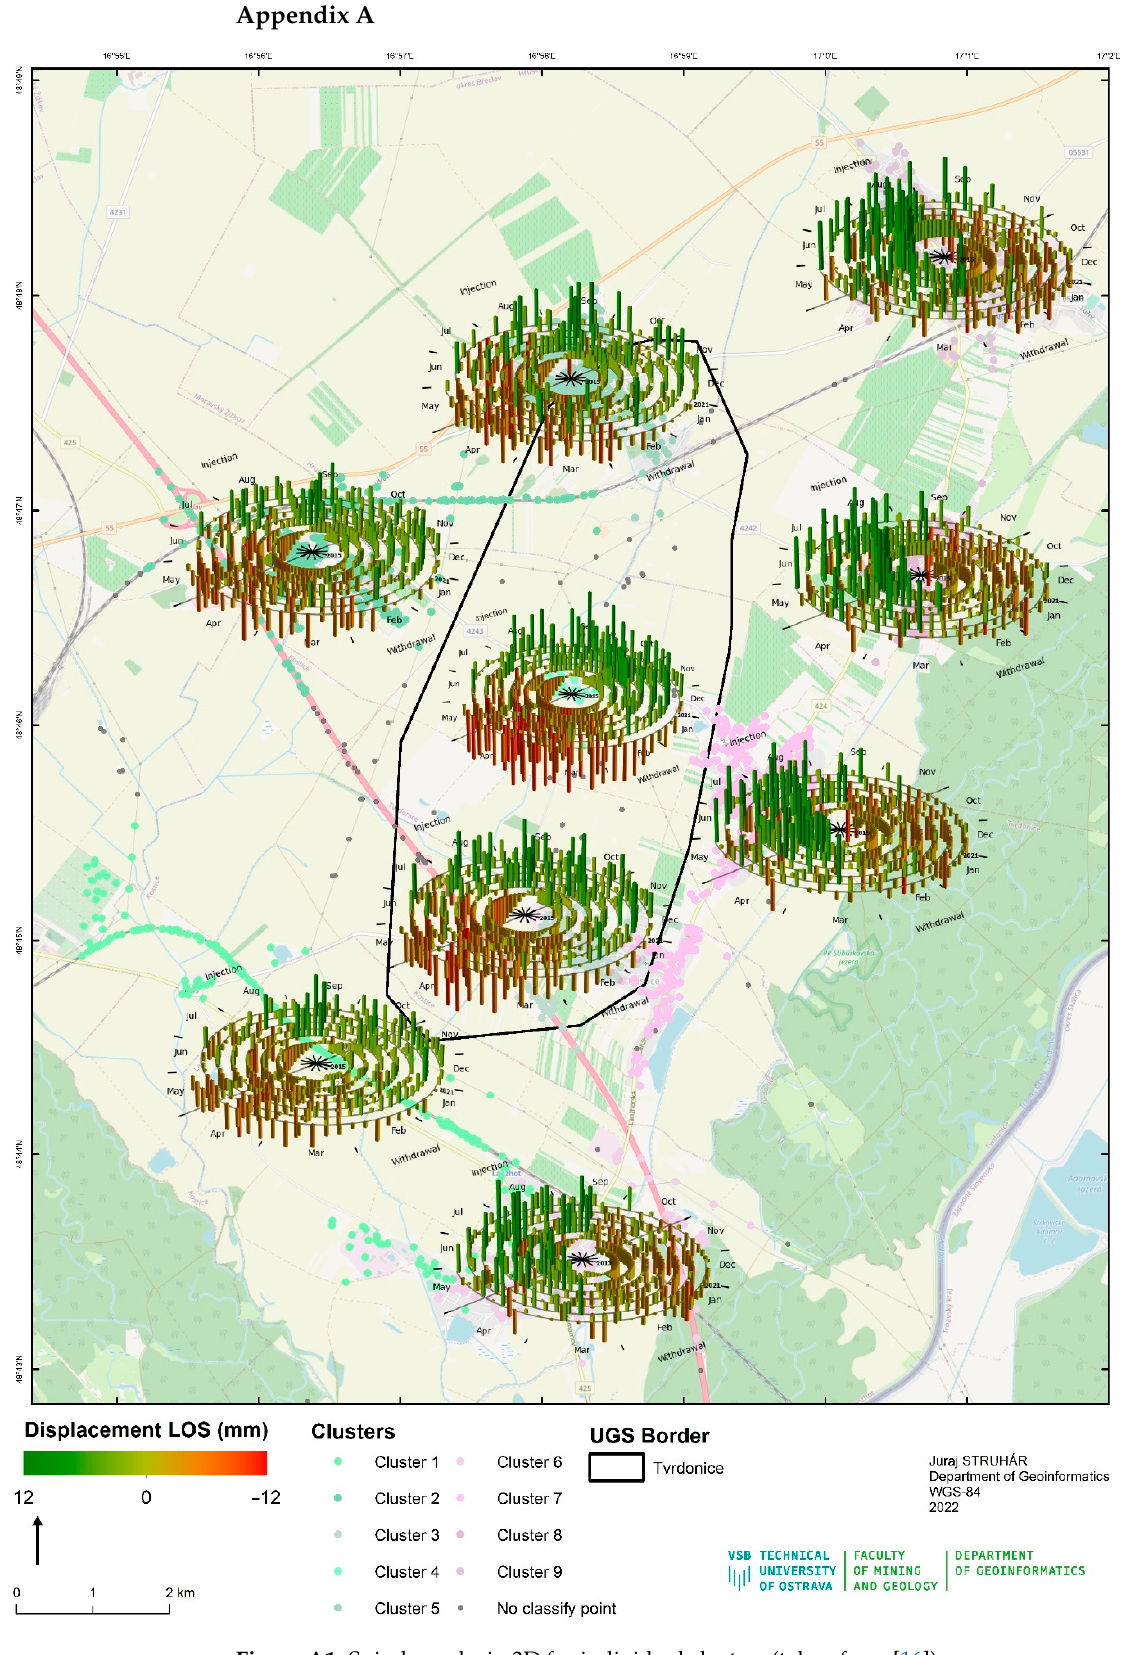
Figure A1. Spiral graphs in 3D for individual clusters (taken from 16 ).